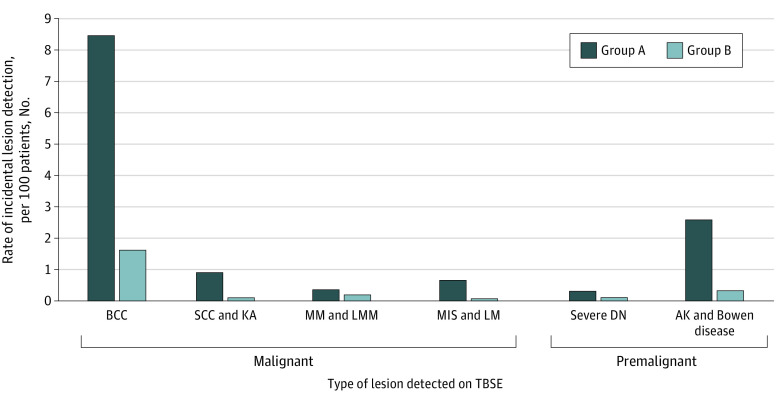
Rates of Detection of Incidental Skin Lesions by Total Body Skin Examination (TBSE) According to Skin Lesion TypeAbbreviations: AK, actinic keratosis; BCC, basal cell carcinoma; DN, severely dysplastic nevus; KA, keratoacanthoma; LM, lentigo maligna; LMM, lentigo maligna melanoma; MIS, melanoma in situ; MM, malignant melanoma; SCC, squamous cell carcinoma.